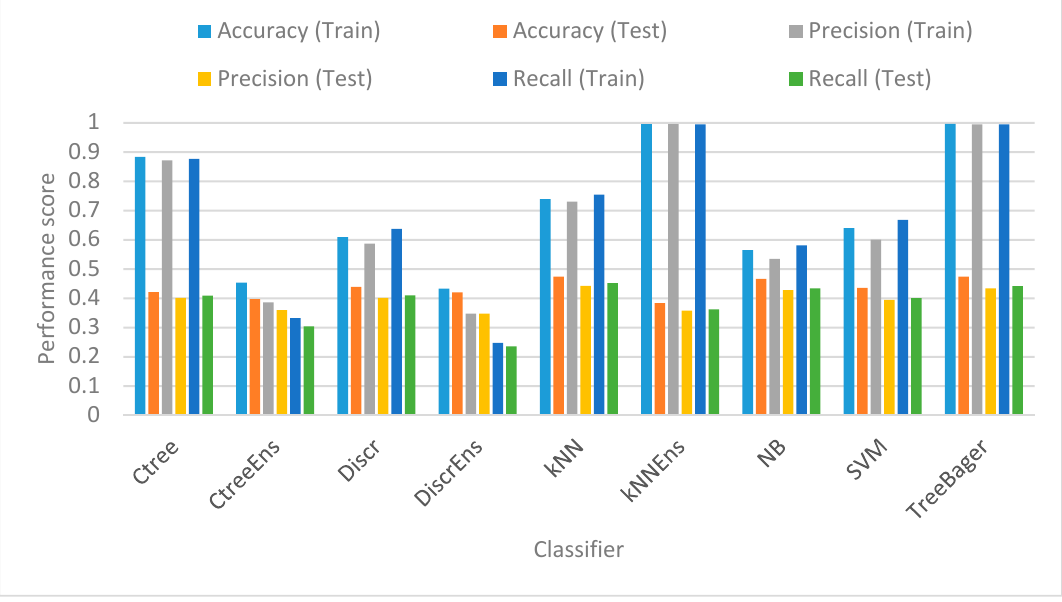
Figure 5. Classifiers’ performance scores.